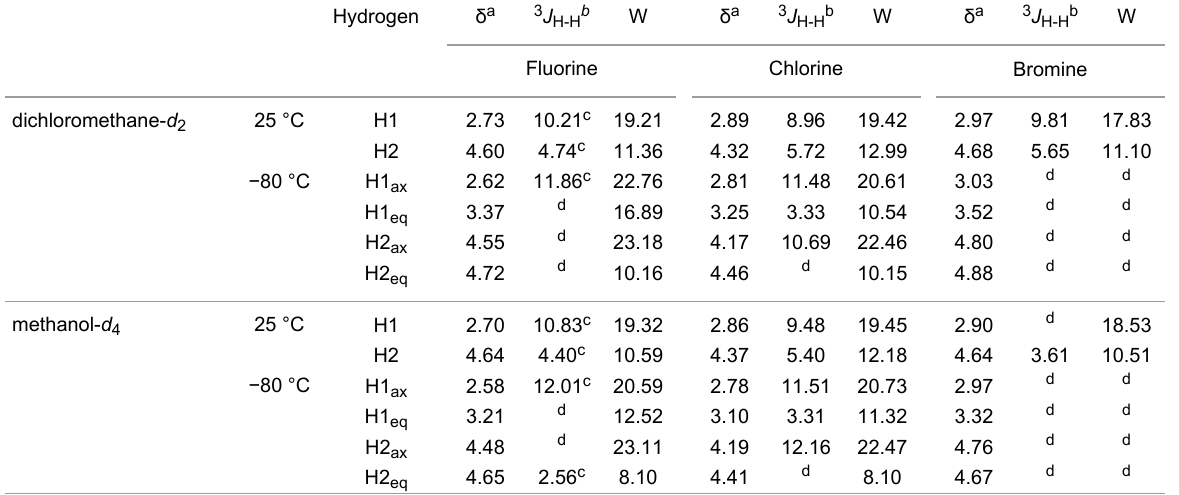
Table 1: Chemical shifts ( δ , ppm), coupling constants ( 3 J H–H , Hz) and half-height line width (W, Hz) for cis -2-halocyclohexylamines in different sol- vents at 25 °C and − 80